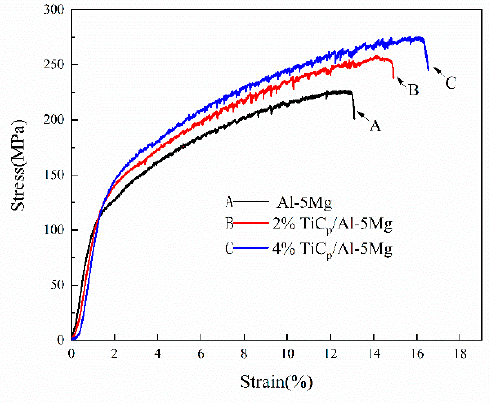
Figure 7. Engineering stress–strain curves of the welds.